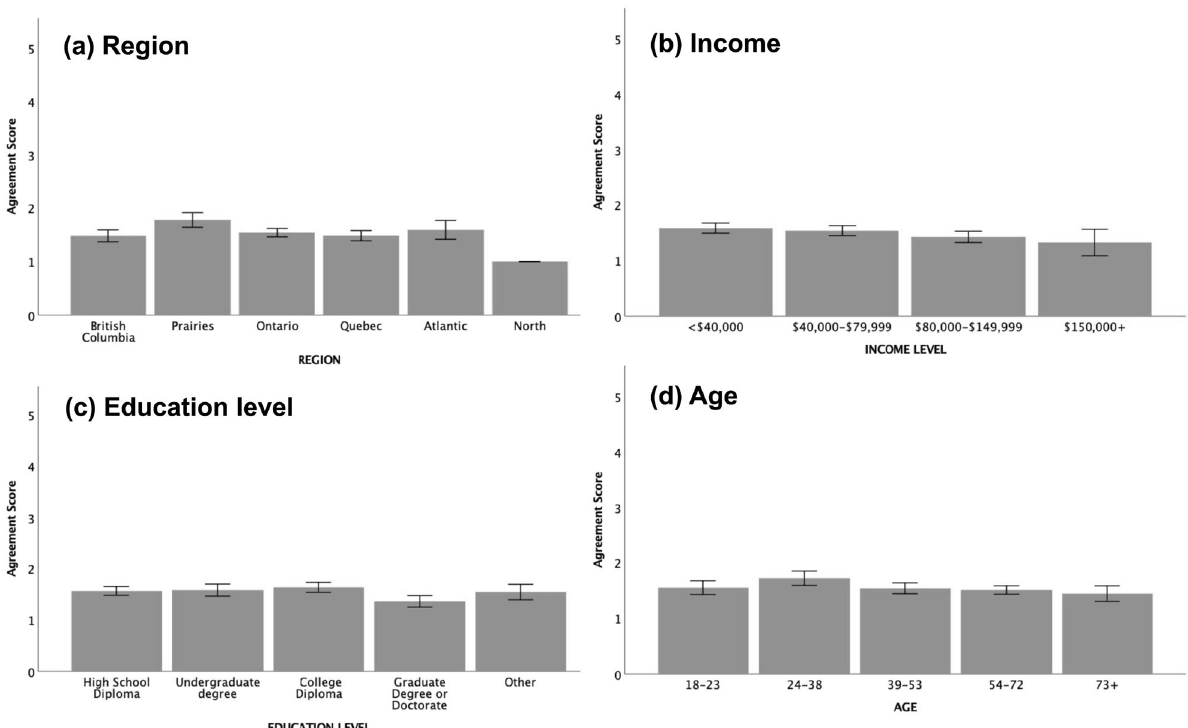
Fig. 2 Consumer motivation to reduce the amount of single-use plastic food packaging by region, income, education level, and age. Panels indicate region ( a ), income ( b ), education level ( c ), and age ( d ). Error bars indicate standard